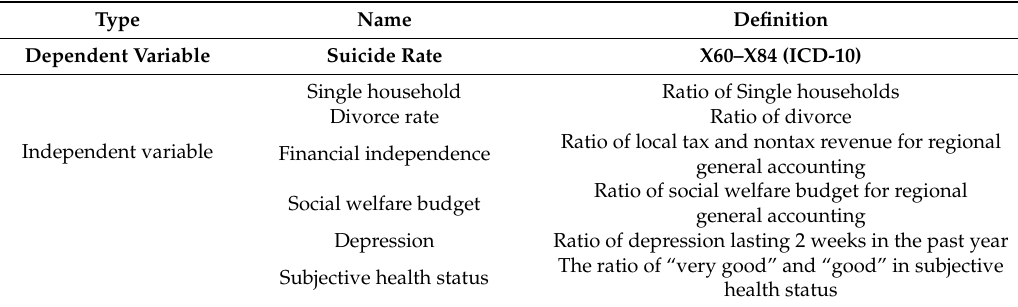
Table 1. Variables and their